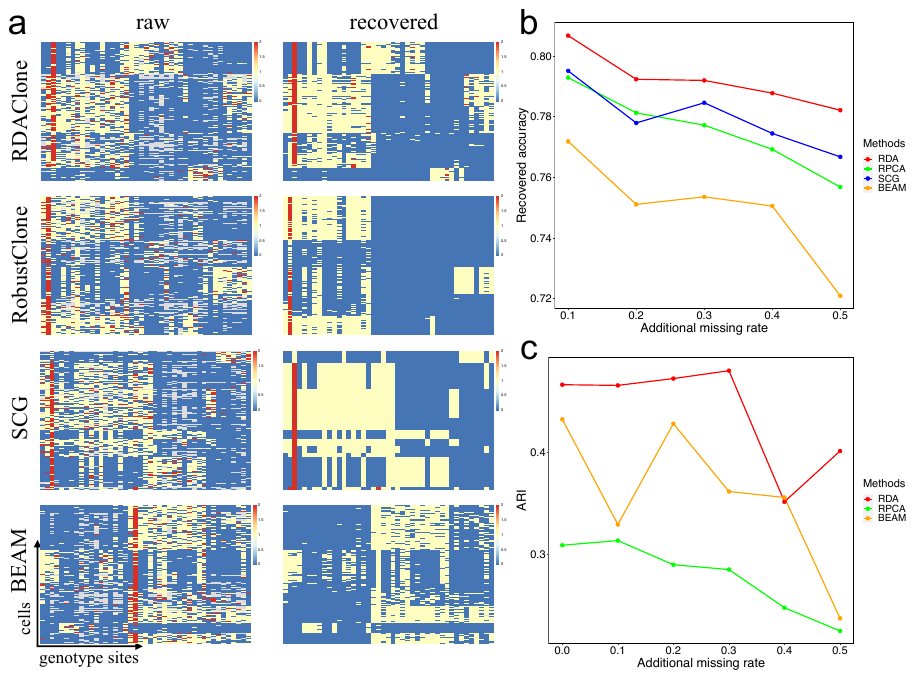
Figure 3. Genotype matrix recovery, and cell clustering on the HGSOC dataset. ( a ) The heatmap of raw and recovered genotypes matrix for each of methods: RDAClone, RobustClone, SCG and BEAM. The ordering of cells and genotype sites based on the clustering of recovered matrix. ( b ) The proportion of missing entries correctly recovered by RDAClone, RobustClone, SCG and BEAM under five sparsity data generated by additional missing rate. ( c ) The clustering accuracy was evaluated by ARI between the published SCG results and clustering results of recovered matrix by RDAClone, RobustClone and